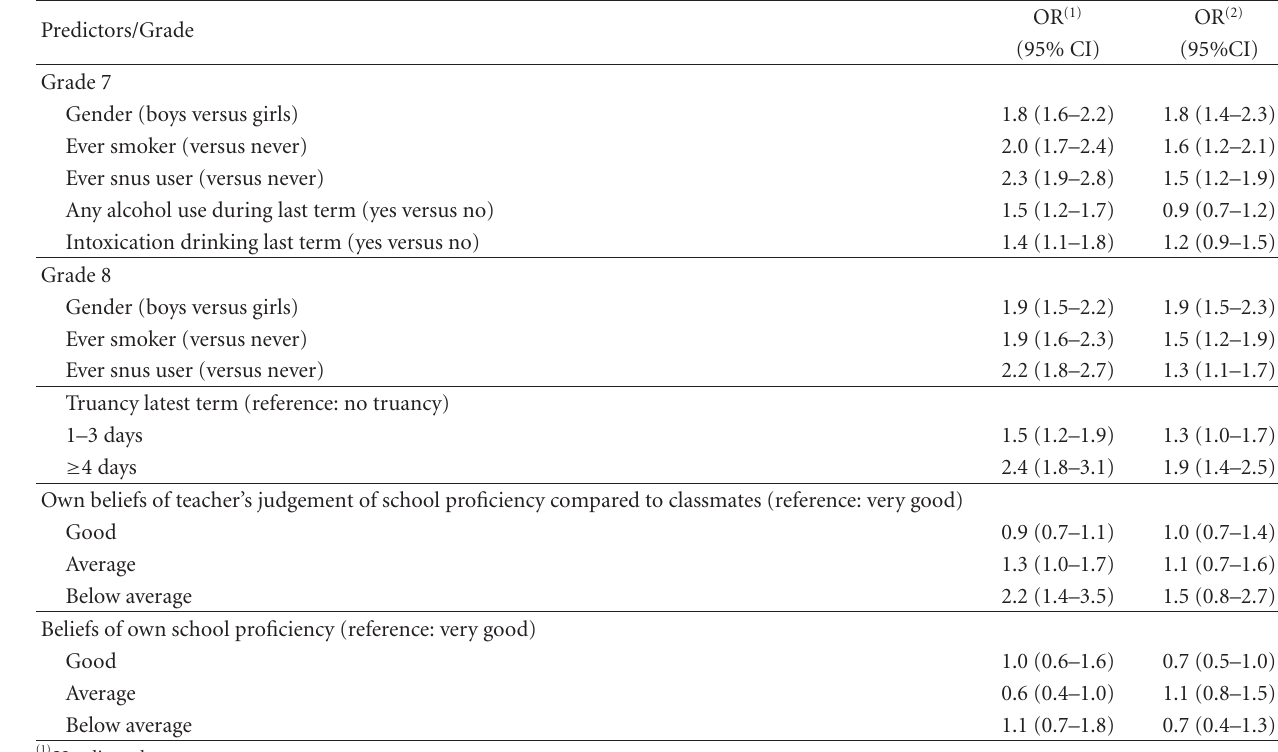
Table 5: Odds ratios of nonparticipation according to behavioural and psychosocial characteristics at di ff erent times during followup.